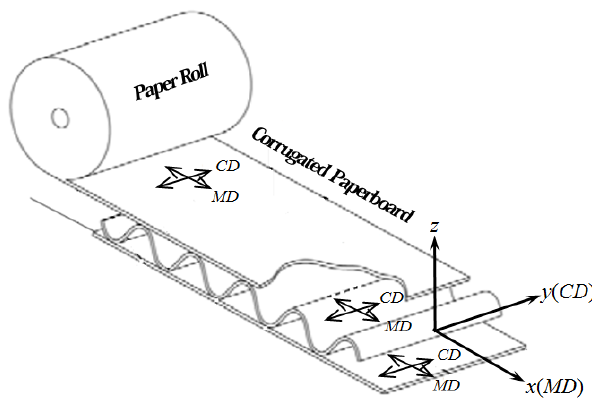
Figure 1. Three principal material axes in corrugated paperboard and its components.